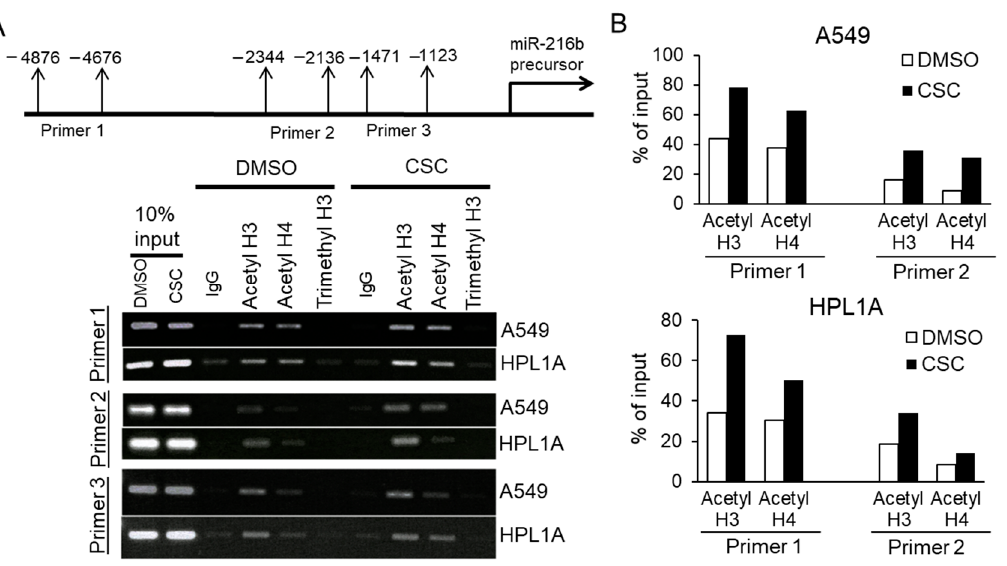
Figure 7. Role of histone acetylation in miR-216b gene expression. ( A ) Long-term CSC or DMSO-treated HPL1A and A549 cells were cross-linked by formaldehyde for 0.5 h and then terminated with glycine. ChIP assay was performed using rabbit anti-acetylated histone H3, rabbit anti-acetylated histone H4, rabbit anti-tri-methyl-histone H3 (Lys 27), and control rabbit IgG. The resulting DNA was purified and analyzed by PCR using primers (as indicated) that recognize promoter sequences of miR-216b precursor. ( B ) Densitometry of PCR products for DNA pulled down with anti-acetylated histone H3 and anti-acetylated histone H4 antibodies, and targeted by two primer sets that recognize promoter sequences of miR-216b precursor, was performed using